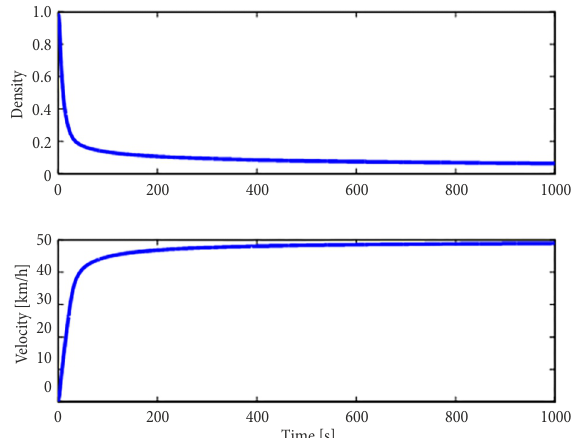
Fig. 5. Traffic density and velocity time